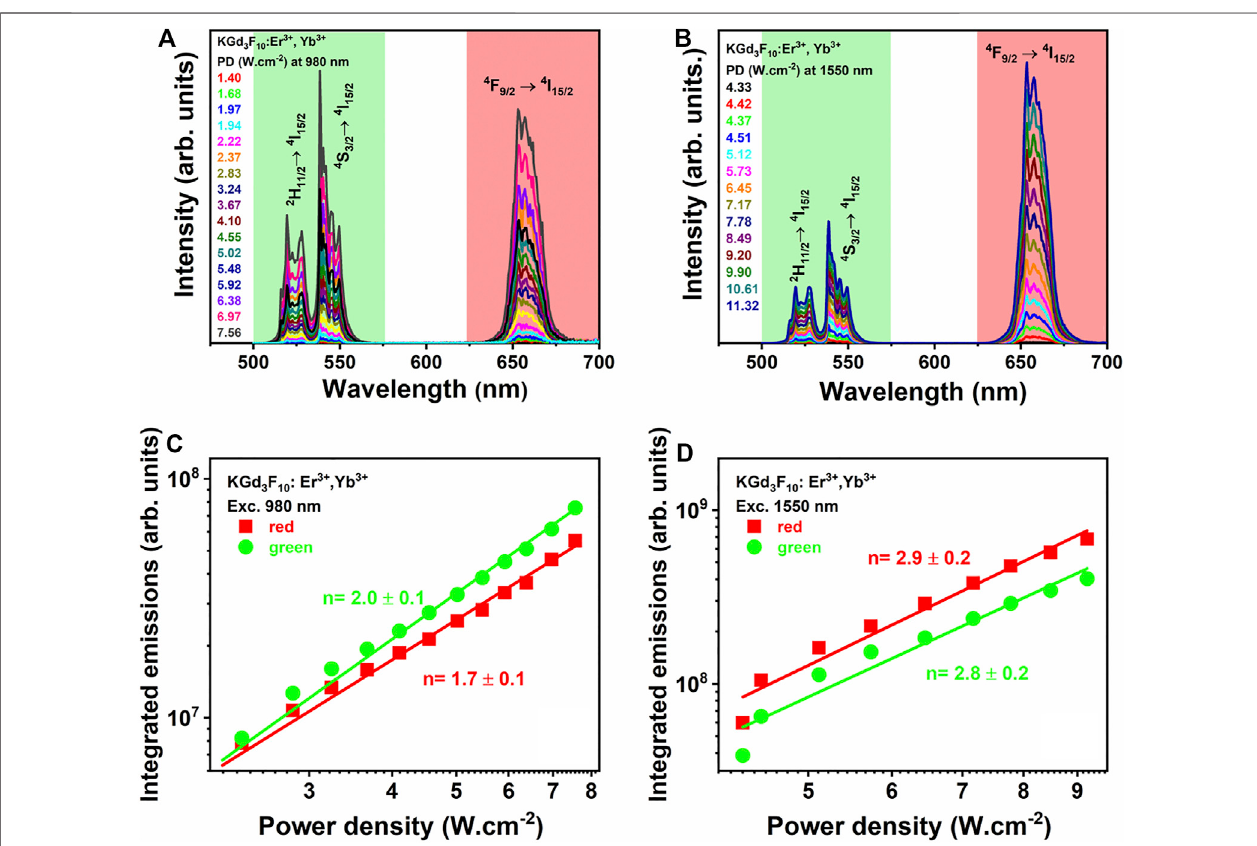
FIGURE 5 | UC emission spectra of the 5% Er 3+ , 20% Yb 3+ : KGd 3 F 10 powder obtained by varying the excitation powers at 980 (A) and 1,550 nm (B) , and the respectivelog-logplotoftheareasundertheUCspectraofthegreenand redemission bandsasafunctionofthe980-and1550 nmexcitation powerdensities (C) and (D) ,